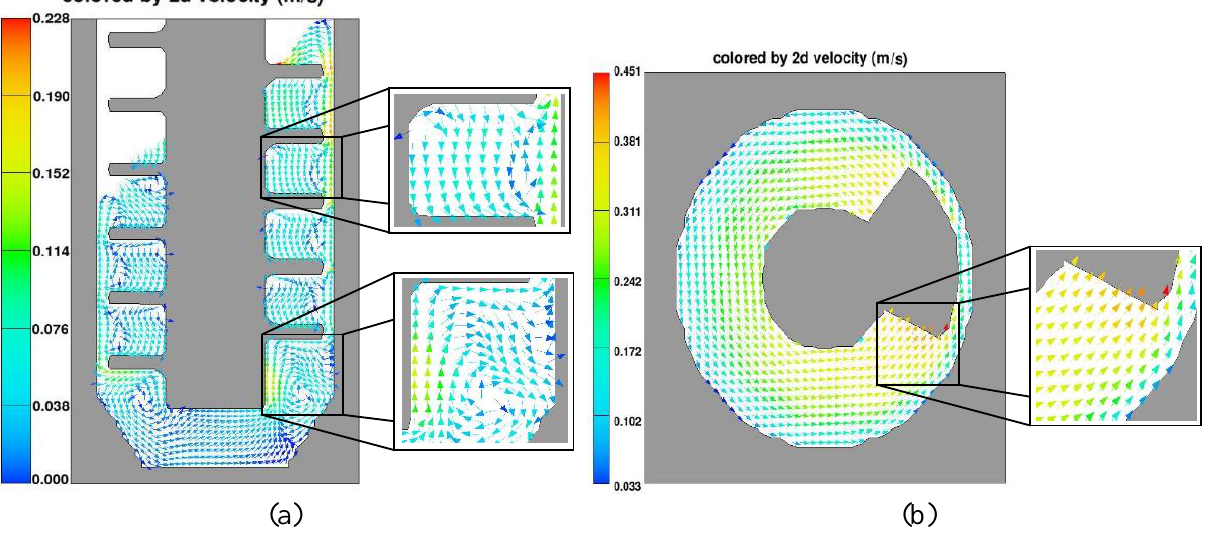
Figure 9. Flow characteristics simulation of the melt in FCM device ( a ) axial velocity vector; ( b ) circular velocity